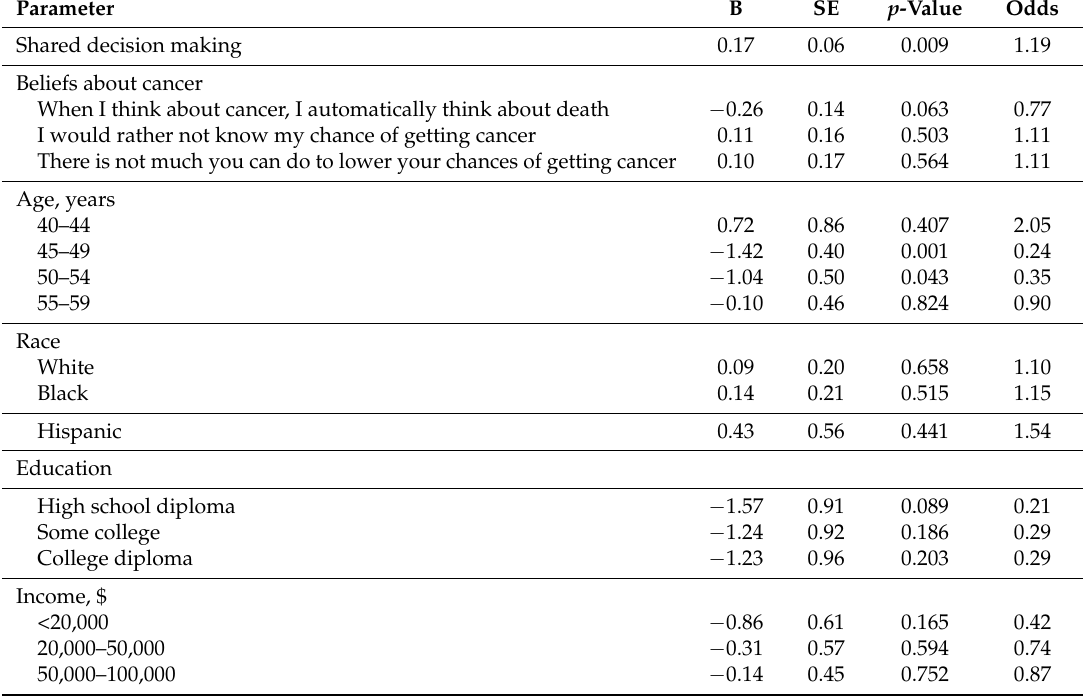
Table 4. Summary of logistic regression analysis for variables predicting women’s adherence to cancer screening guideline by shared decision-making, controlling for beliefs about cancer and socio-demographic